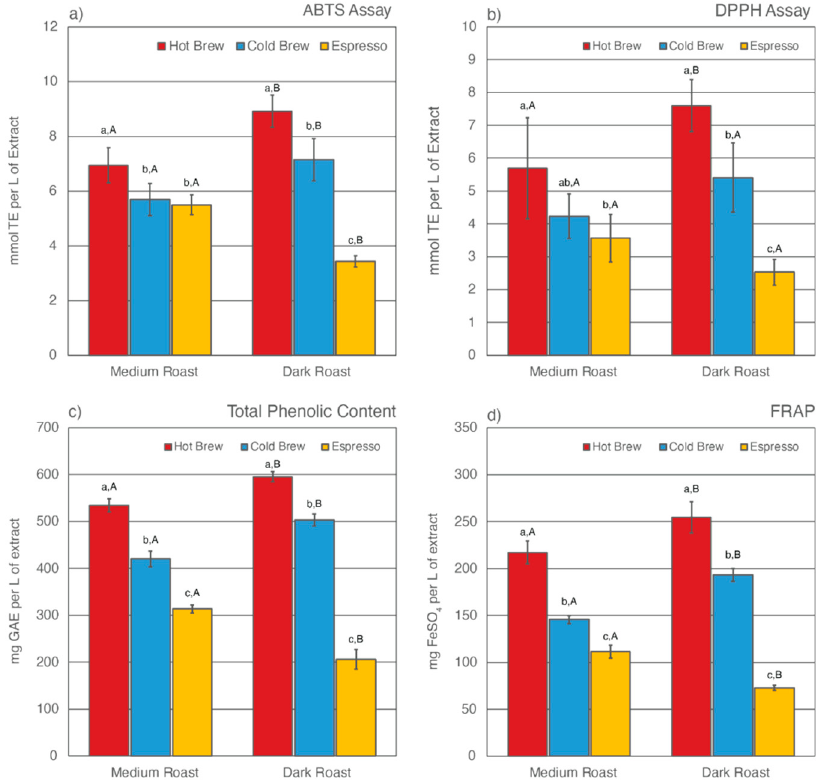
Figure 2. Total antioxidant capacities (TACs) as estimated by ABTS assay ( a ), DPPH assay ( b ), Folin- Ciocalteu assay for total phenolic content ( c ), and ferric ion reducing antioxidant power ( d ) for six SCG extracts. Letters a–c denote significant ( p < 0.05) differences among brewing methods at the same degree of roast as determined by the Tukey HDS post-tests. Letters A and B denote significant differences between medium and dark roast within the same brewing method.